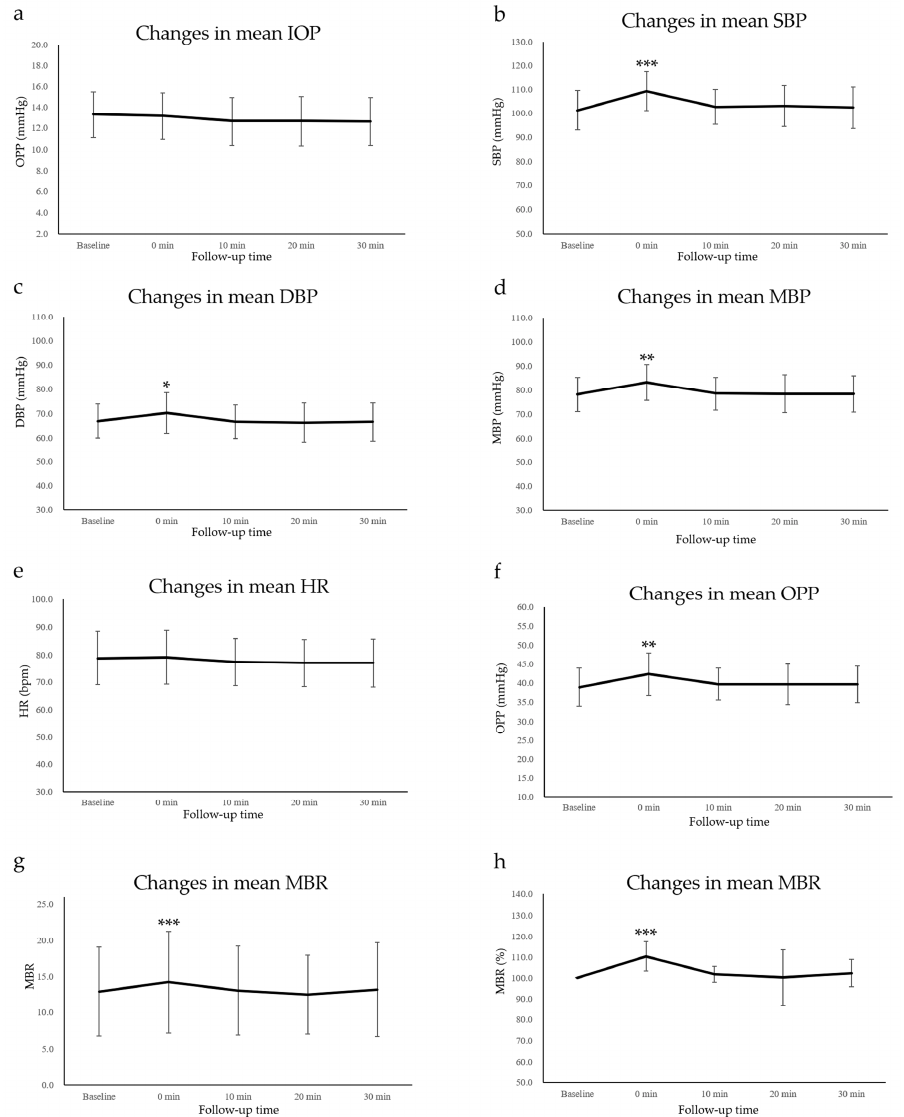
Figure 2. Changes in intraocular pressure (IOP) ( a ), systolic blood pressure (SBP) ( b ), diastolic blood pressure (DBP) ( c ), mean blood pressure (MBP) ( d ), heart rate (HR) ( e ), ocular perfusion pressure (OPP) ( f ), MBR ( g ), and MBR (%) ( h ) at baseline and after the cold pressor tests (* p < 0.05, ** p < 0.01, *** p < 0.001).